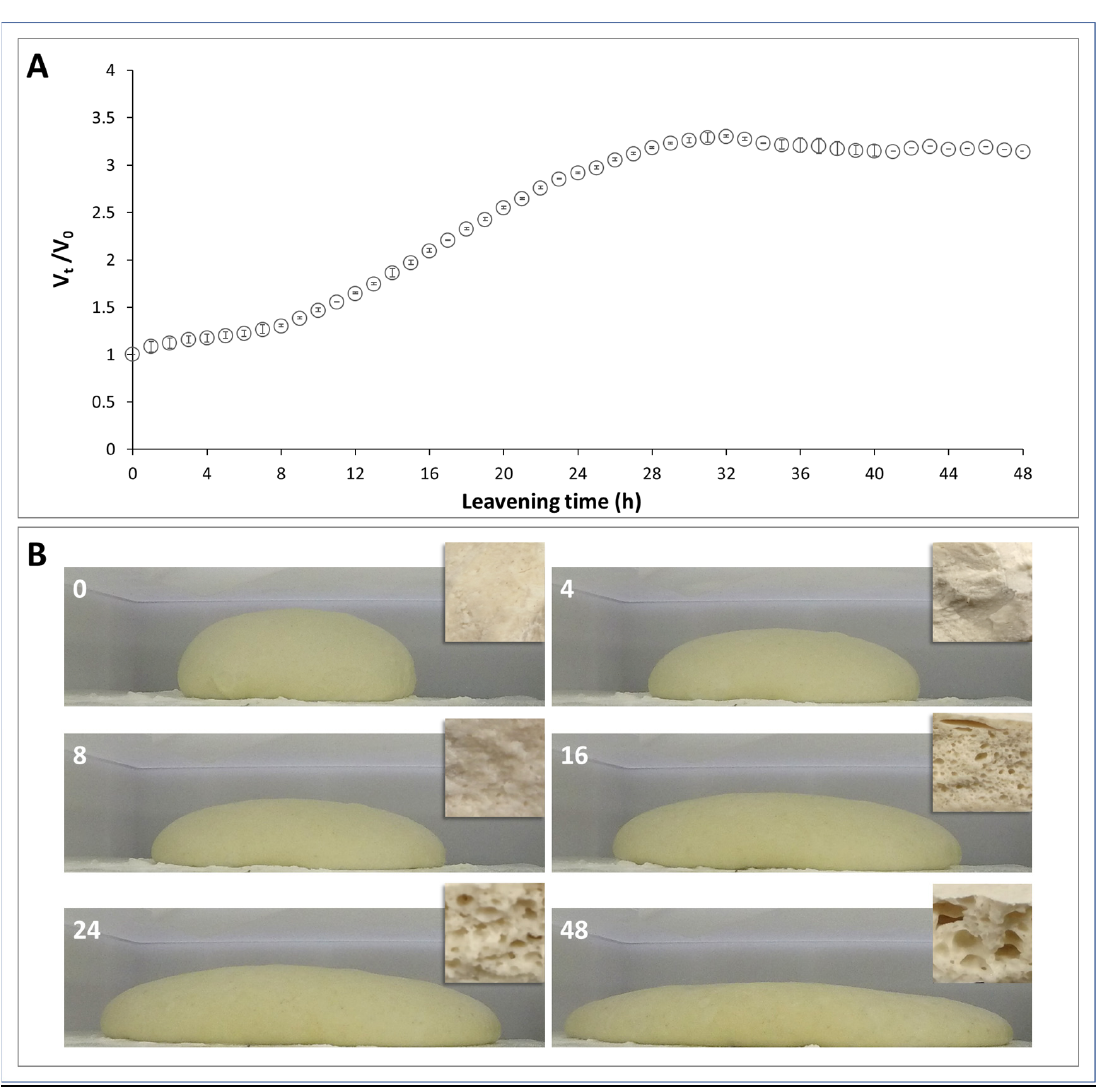
Figure 1. Leavening kinetics of pizza dough. ( A ) Variation of volume index (V t /V 0 ) over time (see also Video S1 in Supplementary Materials); ( B ) images taken at 0, 4, 8, 16, 24 and 48 h. The images inserted at the top right of each photo refer to sections of dough at the corresponding leavening time.